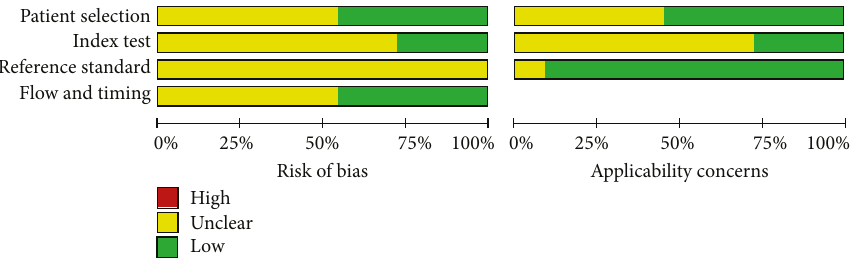
Figure 2: Quality assessment of diagnostic accuracy studies in the meta-analysis. Patient selection, index test, reference standard, and fl ow and timing were assessed of qualities. Patient selection, index test, and reference standard were considered in the applicability concerns. All the included studies were of moderate quality with yellow or greenbars. No high risk existed in these studies with no red bars. Abbreviations: High: high risk; Unclear: unclear risk; Low: low risk.